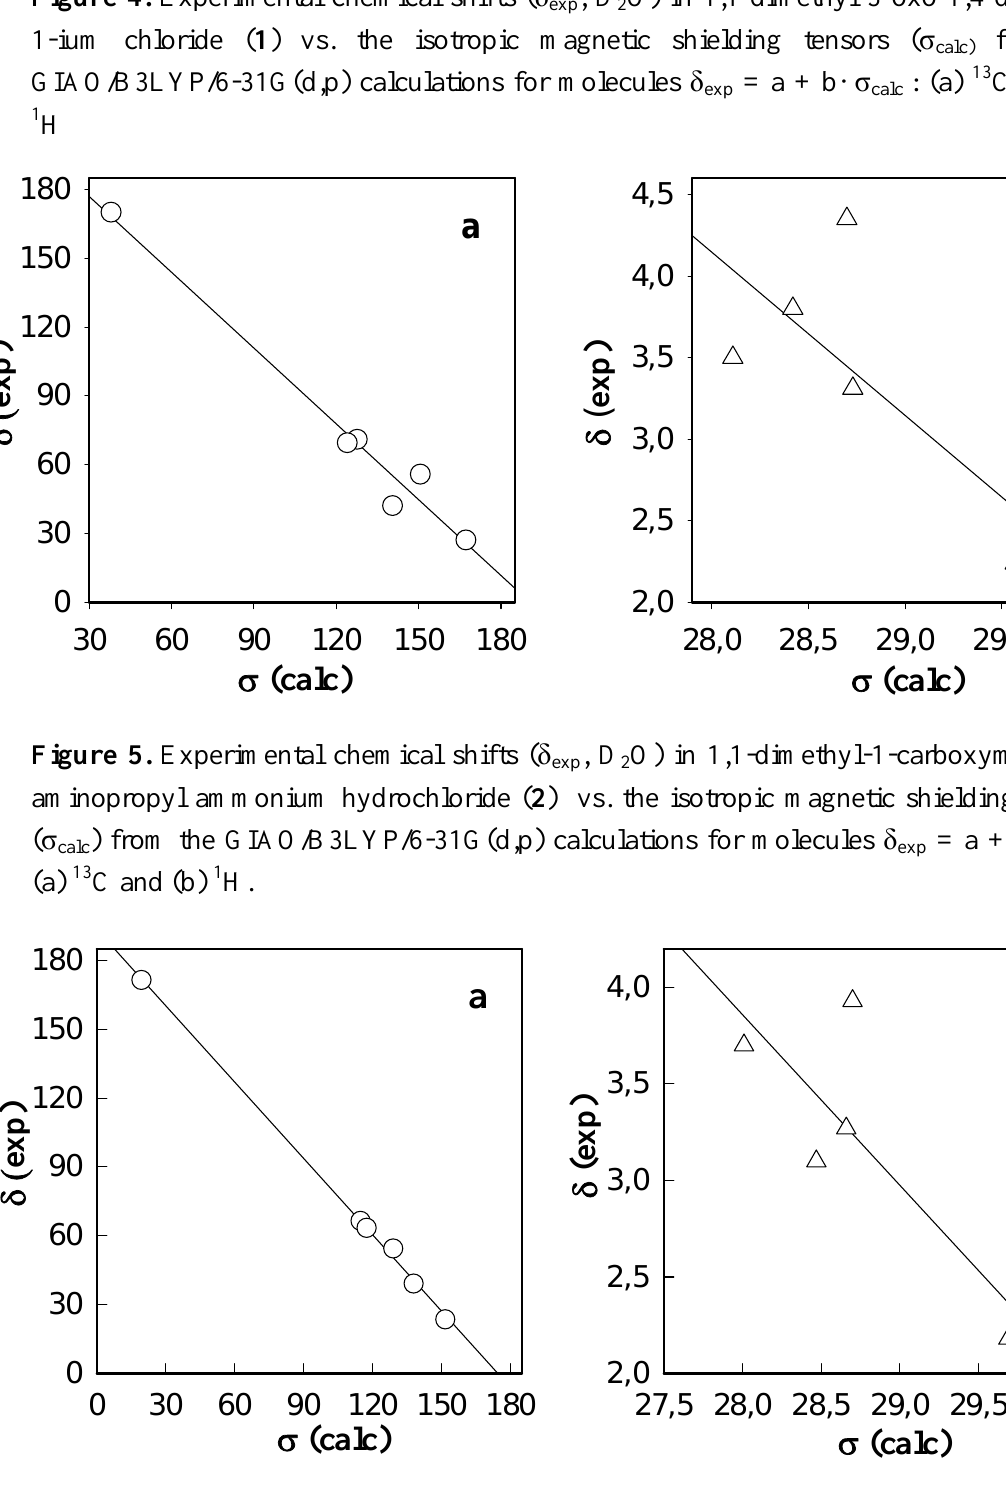
Figure 4. Experimental chemical shifts ( δ 1-ium chloride ( 1 ) vs. the isotropic magnetic shielding tensors ( σ GIAO/B3LYP/6-31G(d,p) calculations for molecules δ